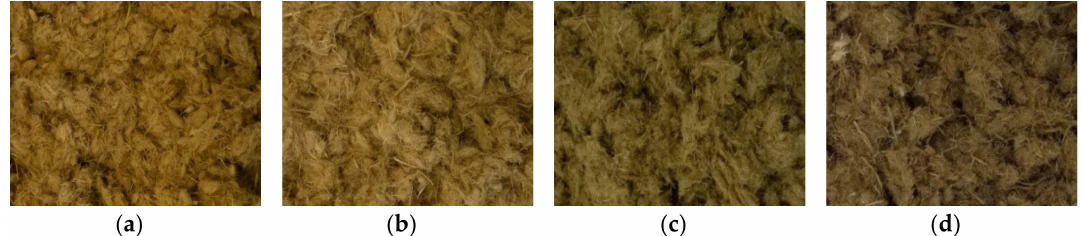
Figure 8. Morphology of MDF sample A after steam refining using di ff erent treatment conditions [log R 0 ; ◦ C; min]: ( a ) 2.47; 150; 10, ( b ) 3.06; 160; 20, ( c ) 3.36; 180; 10, ( d ) 3.95; 190; 20.